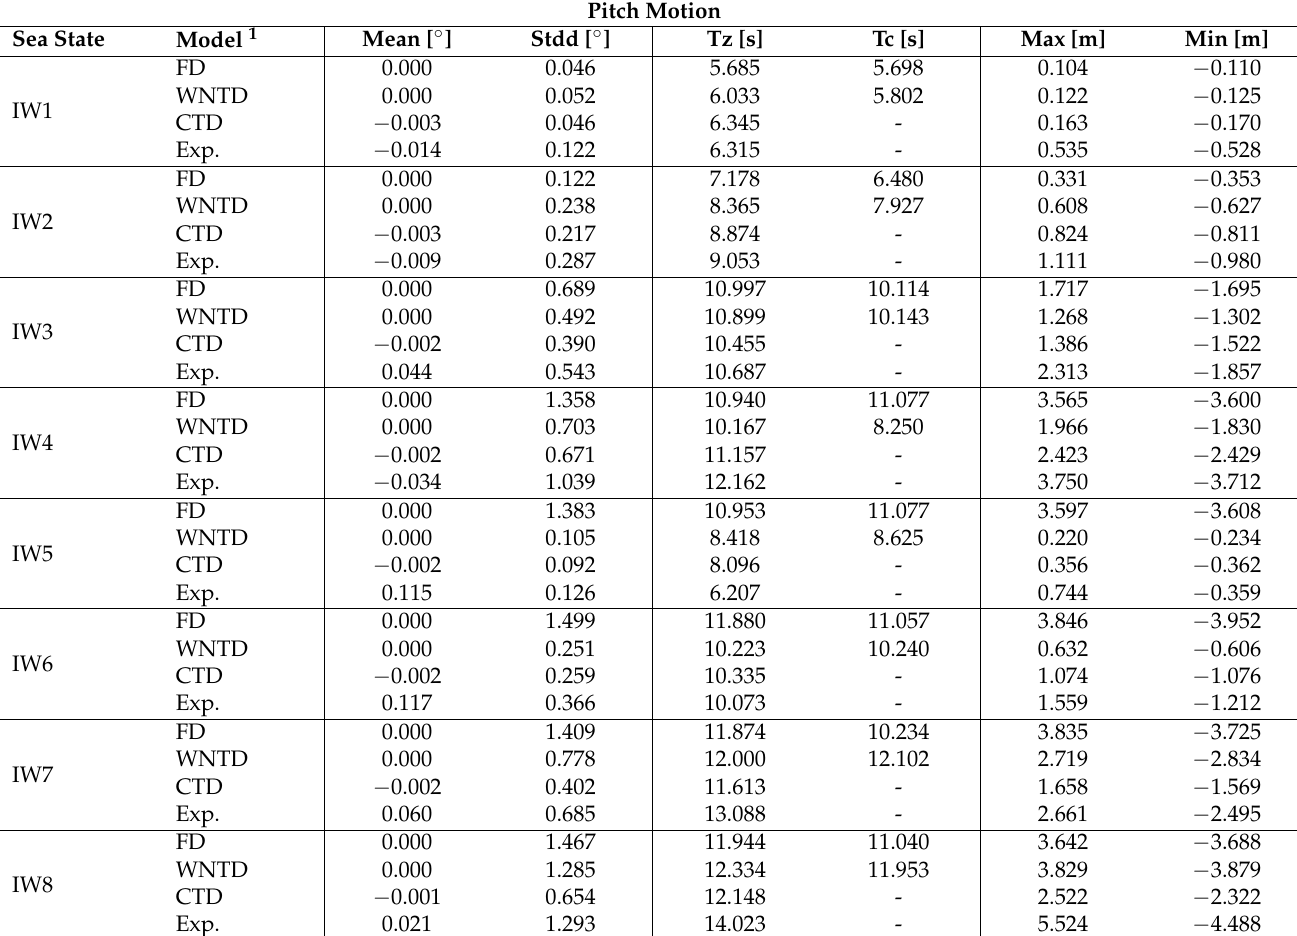
Table 8. Pitch motion statistics in irregular wave conditions according to different